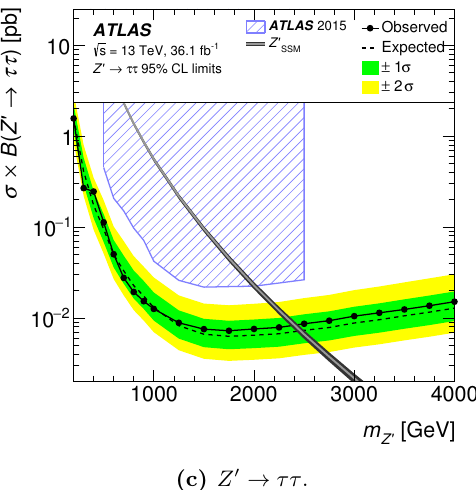
Figure 7. The observed and expected 95% CL upper limits on the production cross section times branching fraction for a scalar boson produced via (a) gluon-gluon fusion and (b) b -associated production, and for (c) gauge bosons. The limits are calculated from a statistical combination of the (cid:28) lep (cid:28) had and (cid:28) had (cid:28) had channels. The excluded regions from the 2015 data ATLAS search [29] are depicted by the hatched blue (cid:12)ll. The predicted cross section for a Z 0 (c), where the band depicts the total uncertainty.